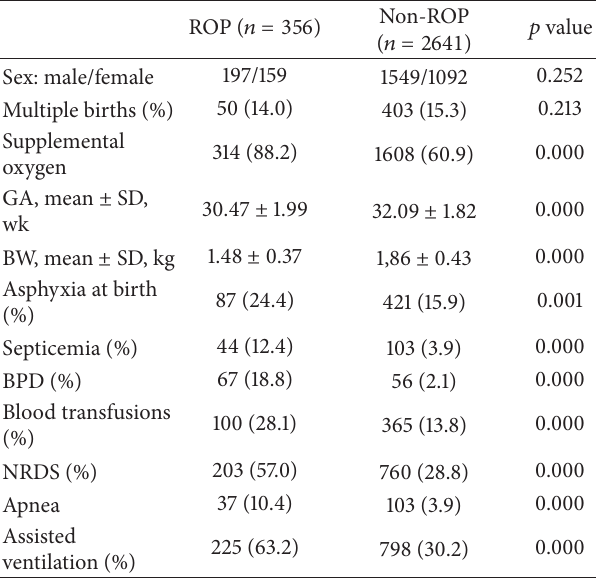
Table 1: The baseline characteristics of ROP and non-ROP infants.